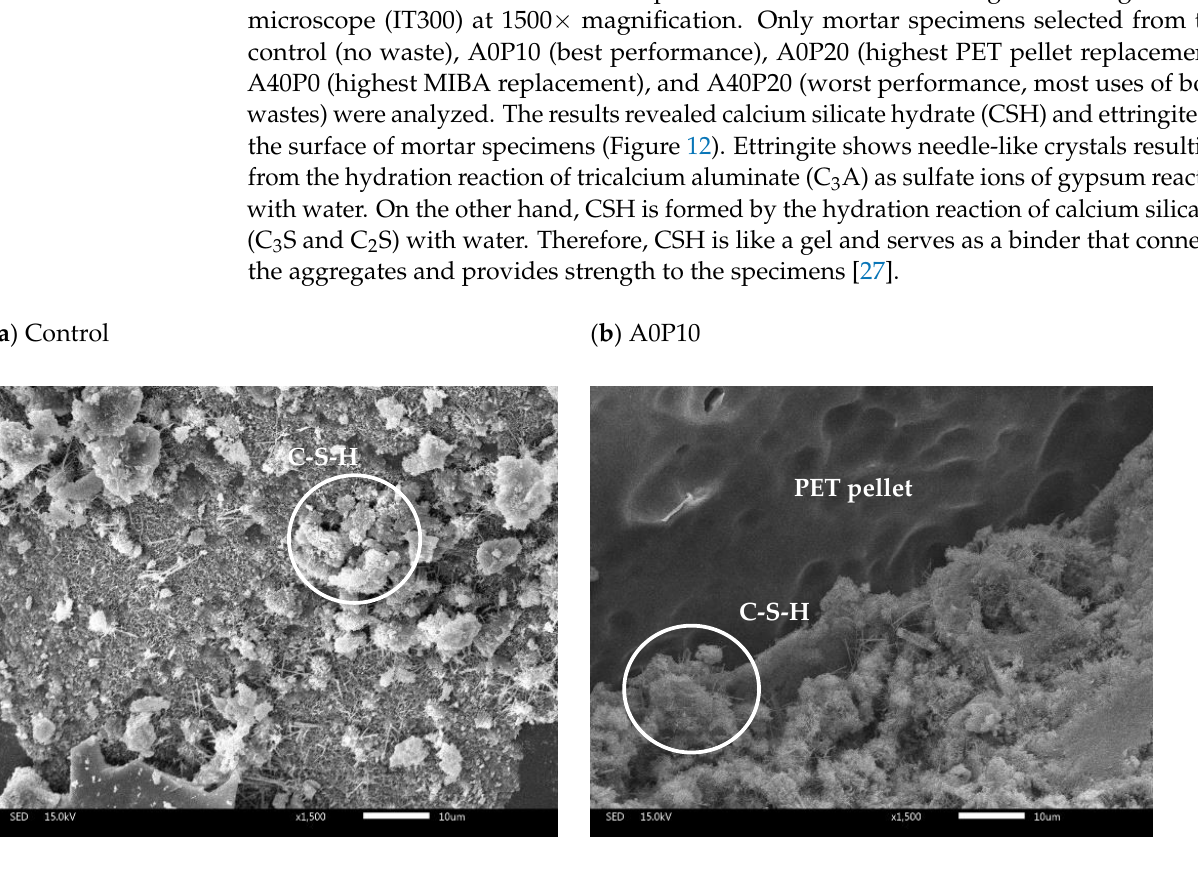
Figure 11. Estimated marginal means of density between PET pellets and MIBA.